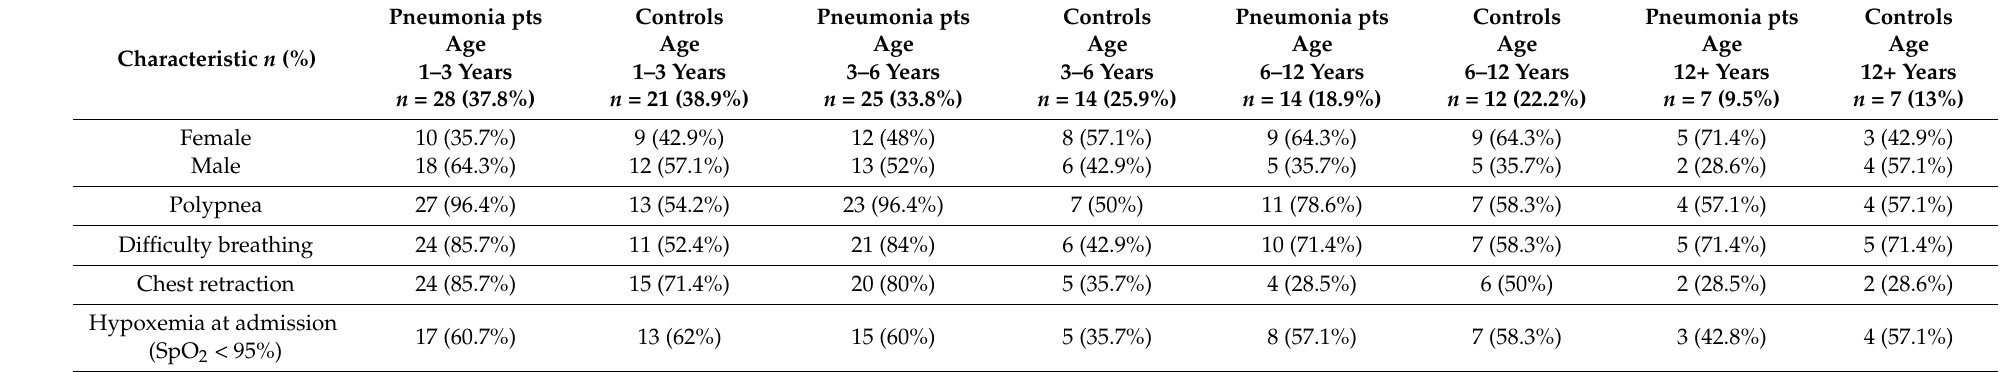
Table 1. Descriptive data and clinical signs of patients diagnosed with pneumonia compared to